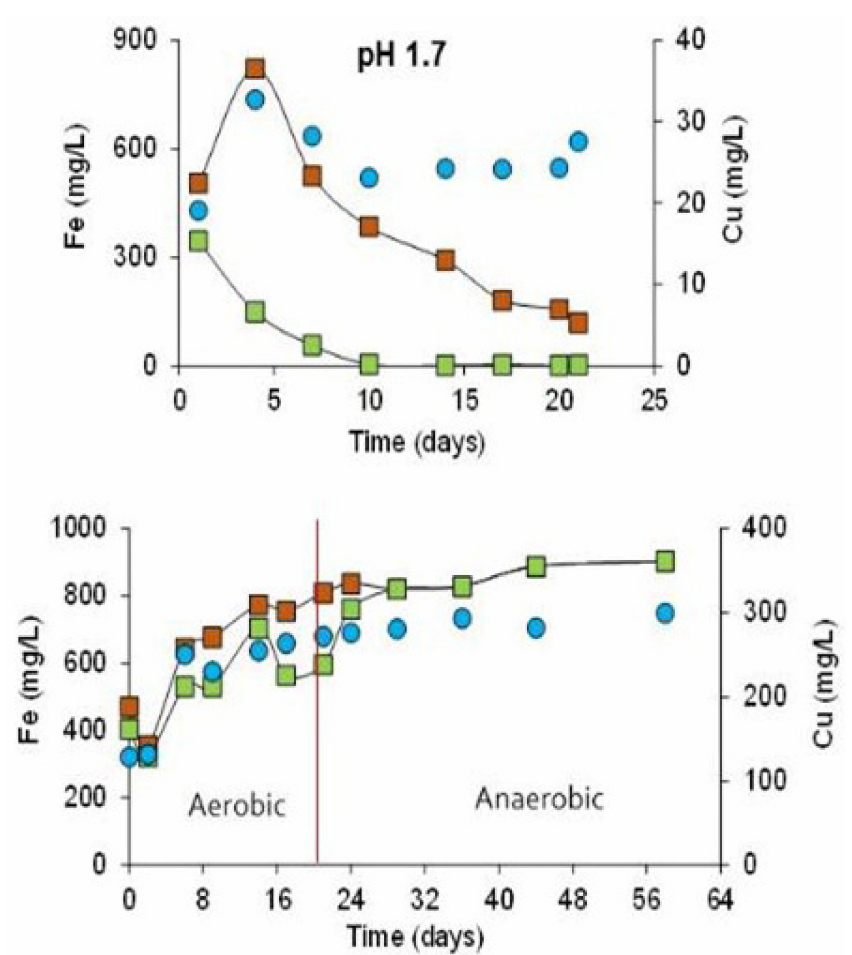
Figure 4. The comparison of aerobic bioleaching of tailings from a copper mine in Spain maintained at a pH of 1.7 by the automated addition of sulfuric acid (top) and SEB of the tailings (with no pH control) carried out under alternating aerobic and anaerobic conditions (bottom), in bioreactors maintained at 45 ◦ C. Key: • , copper; (cid:4) total soluble iron; (cid:4) soluble ferrous